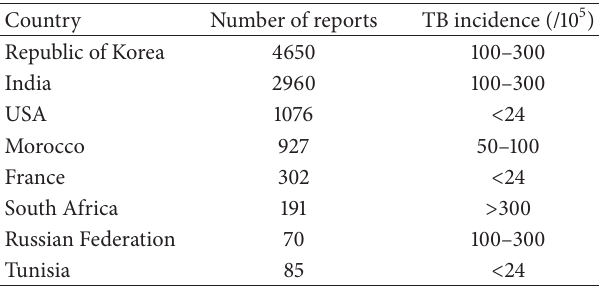
Table 1: International database VigiSearch (January